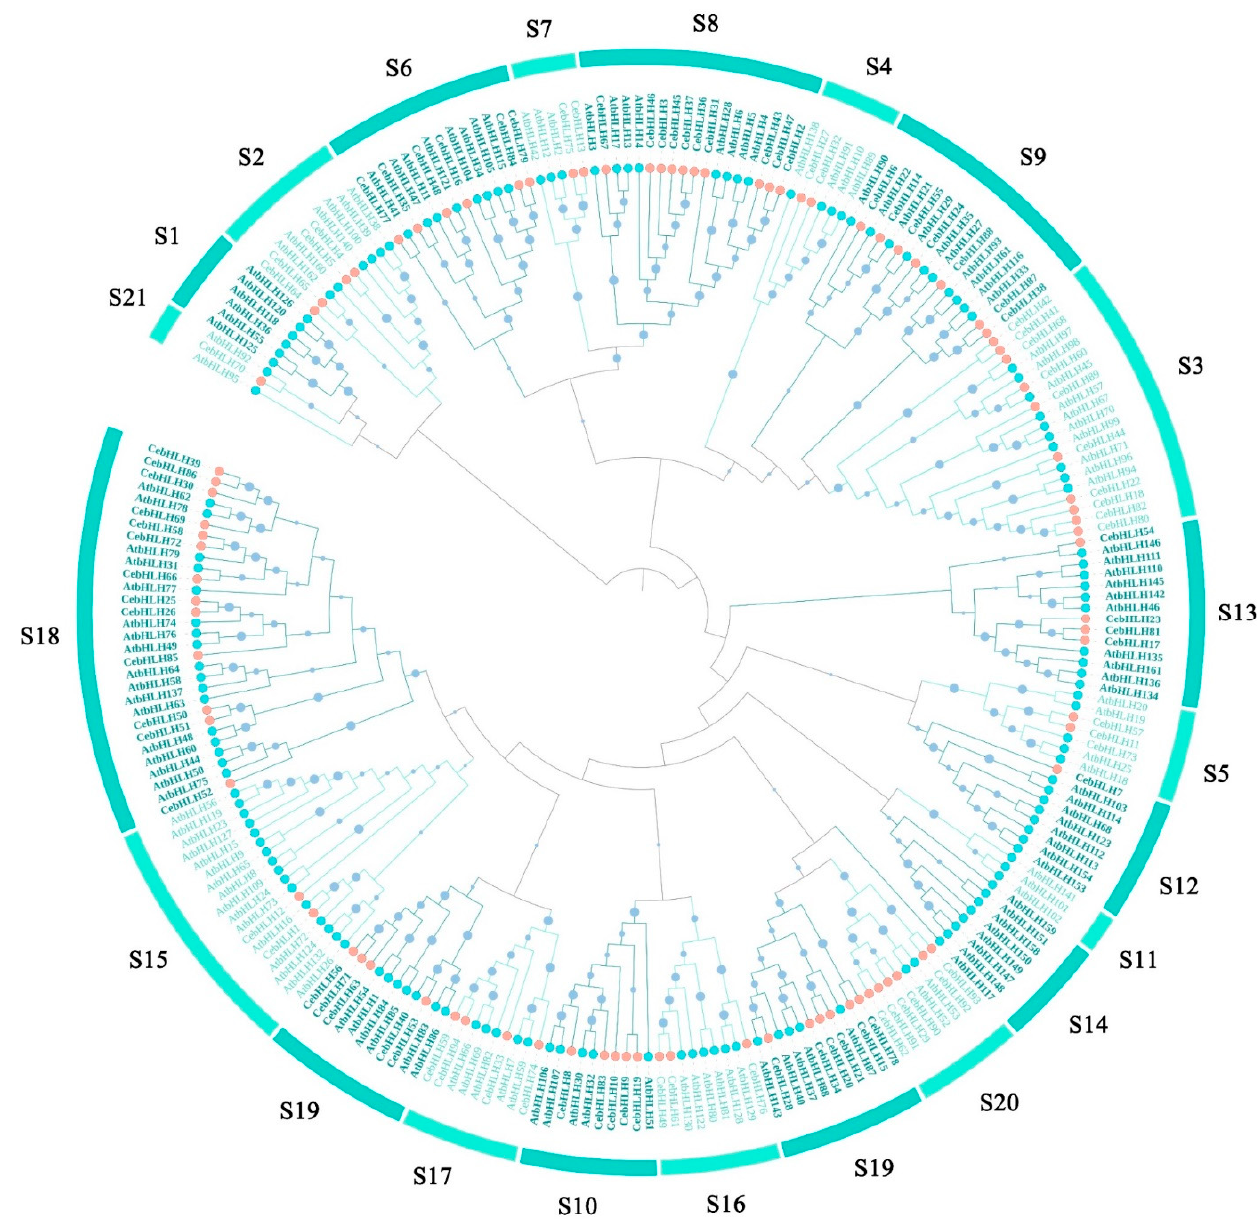
Figure 1. Phylogenetic tree of bHLH proteins based on 94 CebHLH proteins and 152 AtbHLH pro- teins. Orange circles represent CebHLHs, blue circles represent AtbHLHs. S1–S21 represent 21 sub- families.